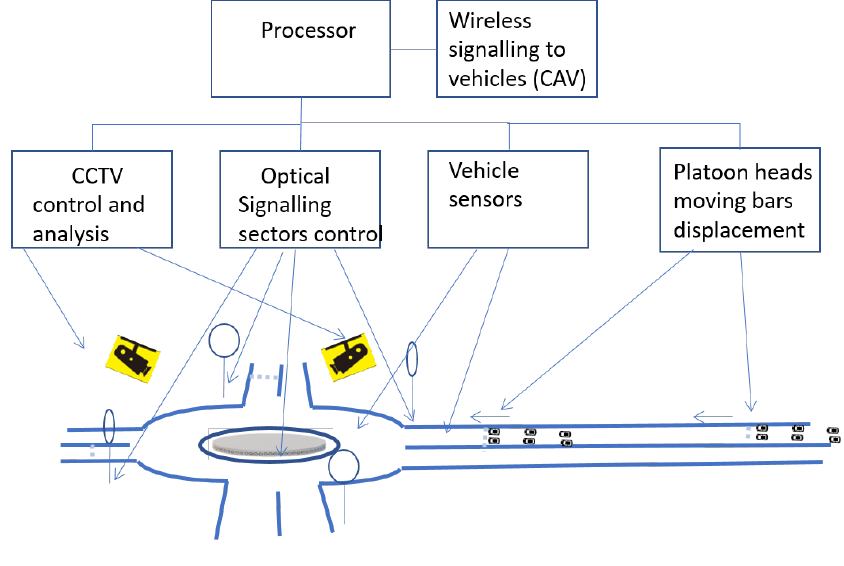
Figure 4. Block diagram of roundabout